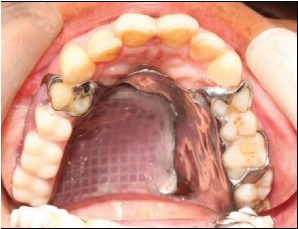
Prosthesis in situ.